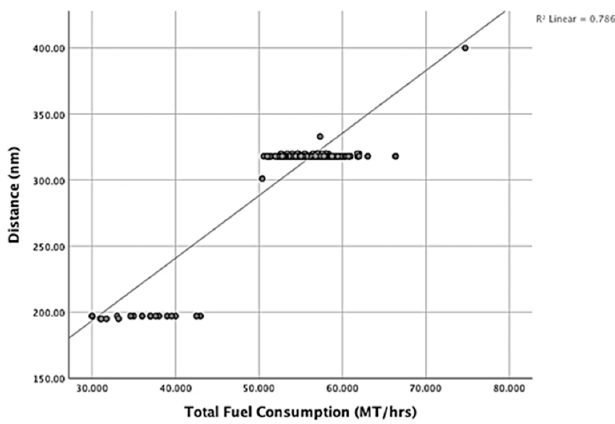
Figure 3. Scatterplot between fuel consumption and distance.